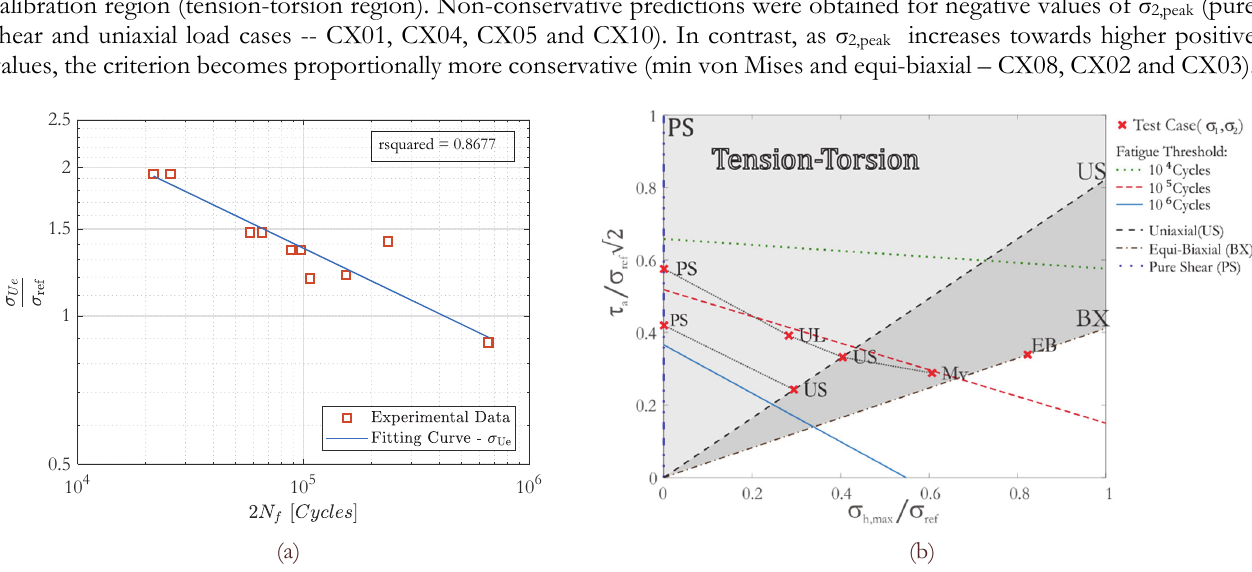
Figure 2: (a) Fatigue life predictions with elastic strain energy density. (b) according to Crossland’s criterion. Strain-based